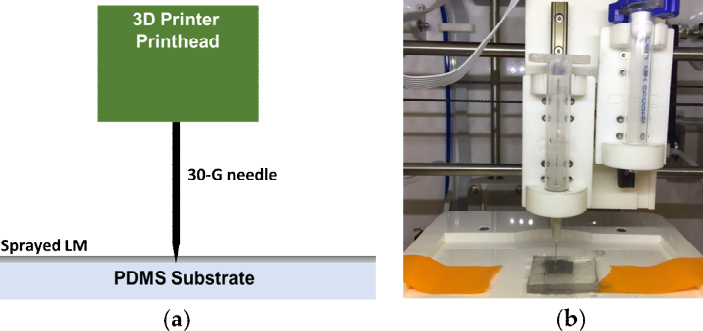
Figure 11. Set-up for scraping sprayed LM: ( a ) Schematic of the set-up, ( b ) photo of the Inkredible 3D Bioprinter, and 30-gauge needle for physically scraping the liquid metal film.